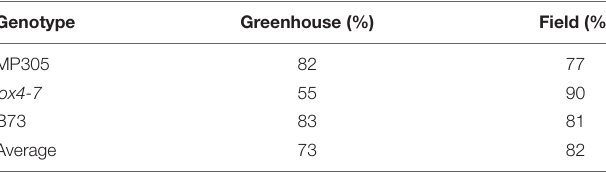
TABLE 1 | Accuracy of leaf-based identification of MP305, lox4-7 , and B73 in the greenhouse and